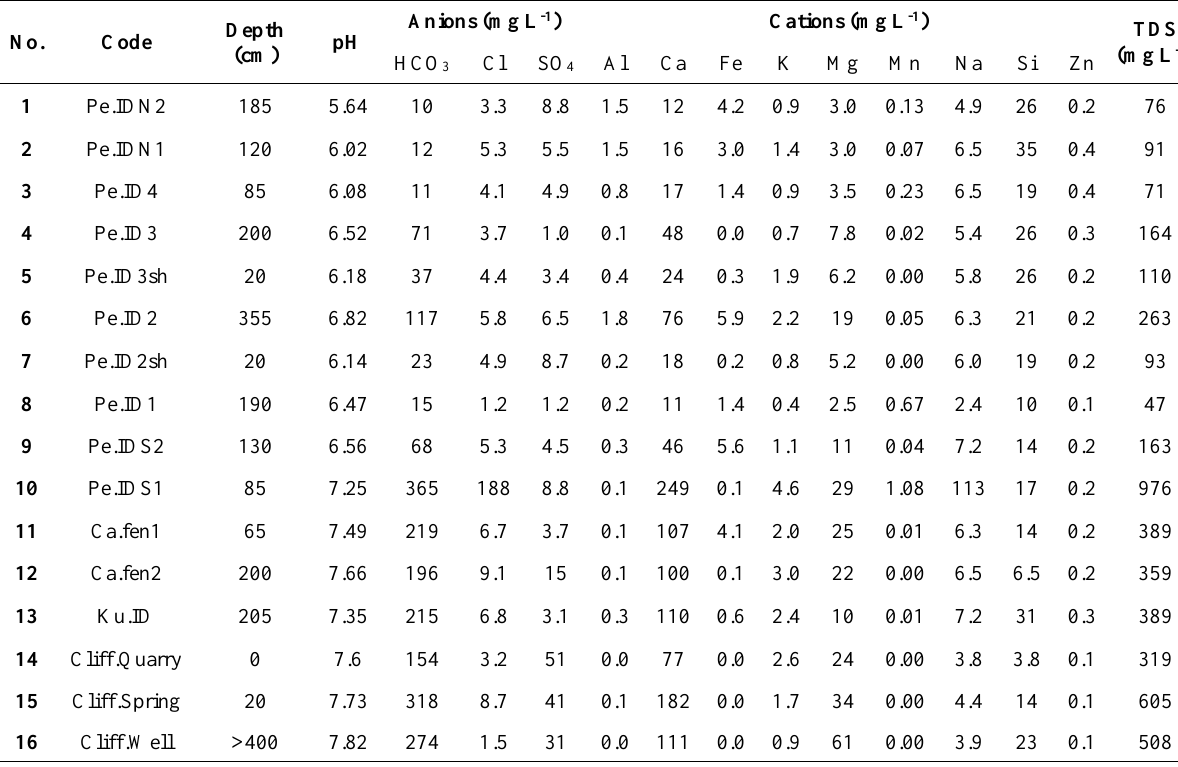
Table 2. Ion composition (mg L -1 ) analysis of 16 groundwater samples from Slitere National Park. Anions (mg L -1 ) Cations (mg L -1 ) Depth No. Code pH (cm) Cl SO